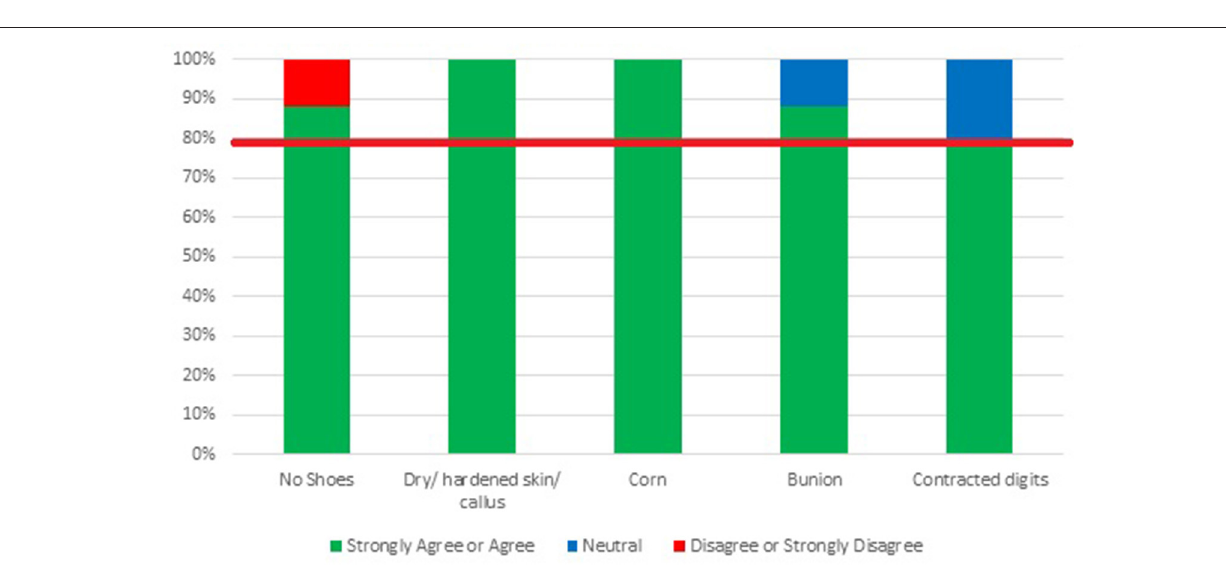
fall risk. The other items that needed clarifying were the foot-pain and foot-deformity